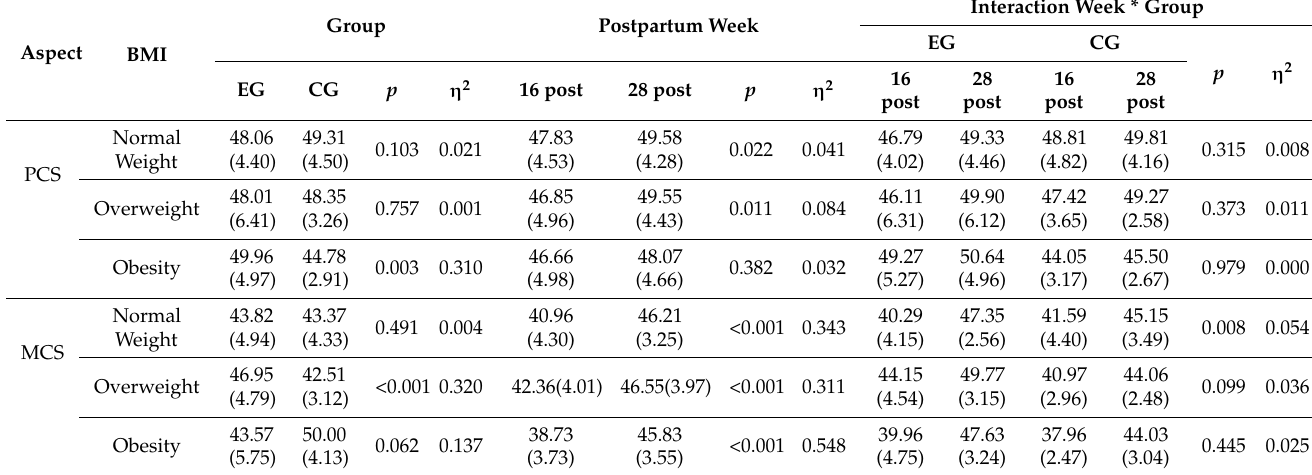
Table 3. Physical component summary and: Mental component summary average score (SD) per group, postpartum week and interaction week * group according BMI. (Normal Weight: EG, n = 32,